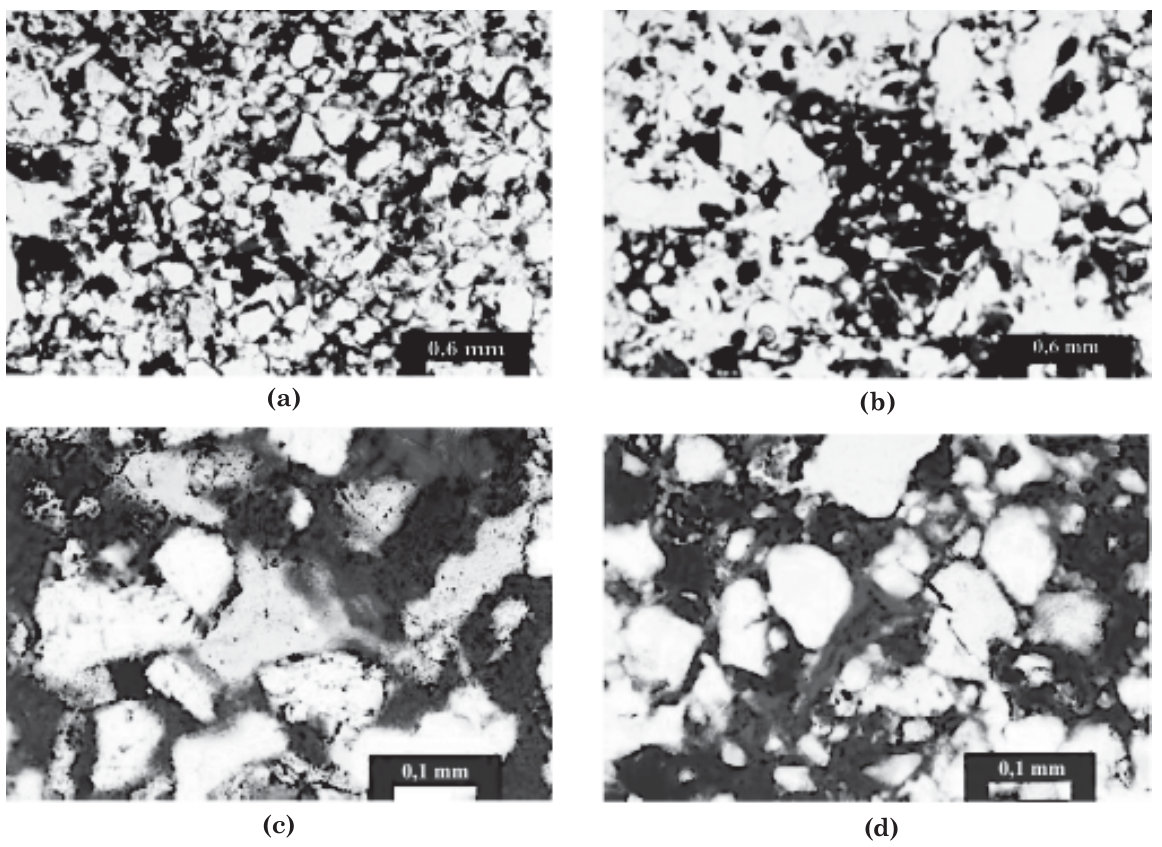
Figura 1. Fotomicrografia das principais características micromorfológicas dos solos analisados. (a) estrutura enáulica e porosidade de empilhamento; (b) bloco subangular com microfissuras e porosidade cavitária; (c) revestimento de argila junto à porosidade; (d) hiporrevestimento dentro de bloco